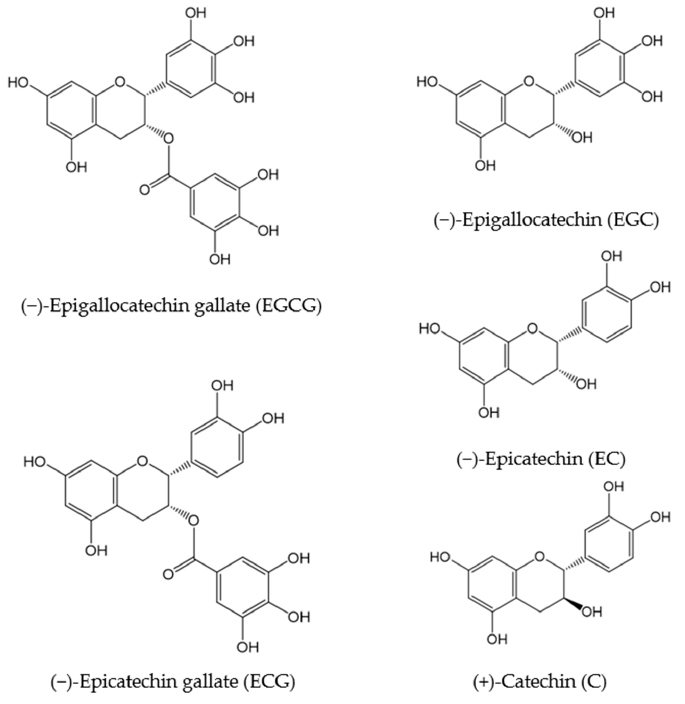
Figure 1. Chemical structures of several catechins.